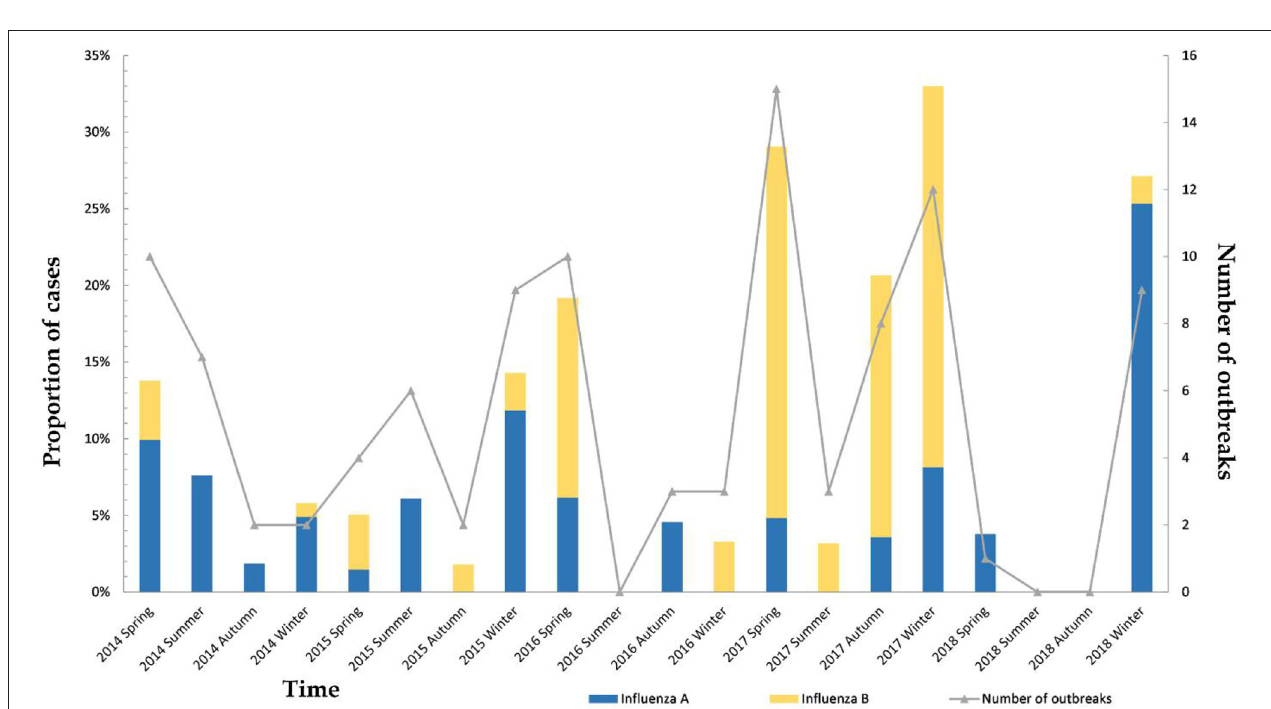
FIGURE 3 | Seasonal distribution of influenza A and B (number of cases and